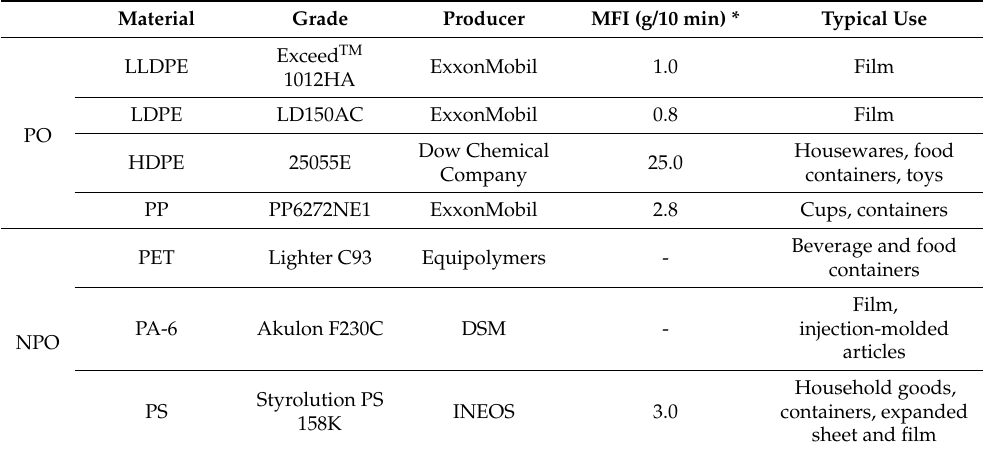
Table 1. Used polymers; data obtained from the respective technical datasheets.